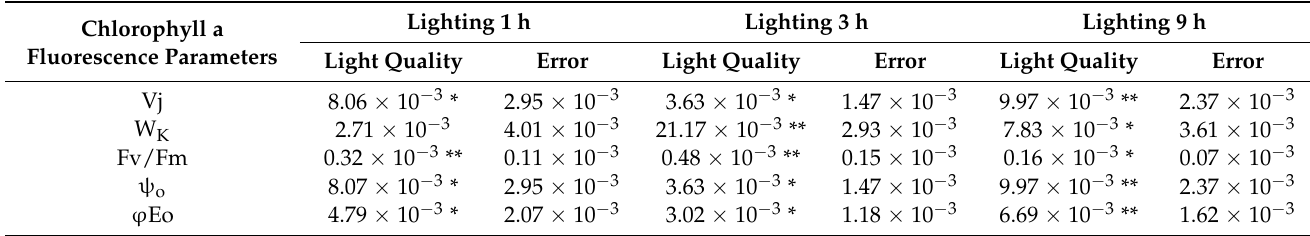
Figure 3. Multiple comparisons of chlorophyll content ( A ), chlorophyll to fresh weight ratio ( B ), photosynthetic enzyme ( C – E ), and gas exchange parameters ( F – I ) of seedlings treated with blue (B), red (R), far-red light (FR), and a combination of B, R and FR lights (CK). Lowercase letters, a, b, represent Duncan group.Light quality significantly affected the photosynthetic parameters (Table 2), and the highest Pn (10.56 µ mol CO 2 m − 2 s − 1 ), Tr (7.04 µ mol H 2 O m − 2 s − 1 ), Gs (0.27 mol H 2 O m − 2 s − 1 ) and Ci (306.48 µ mol CO 2 mol − 1 ) were observed in seedlings treated with R (Figure 3F-I), which were 10%, 80%, 17%, and 57%, respectively higher than those of the control. However, Pn, Tr, Gs, and Ci were all lower for seedlings treated with FR and B than those of the control. Table 3. Summary of ANOVA results comparing chlorophyll a fluorescence parameters of Norway spruce seedlings exposed to four light